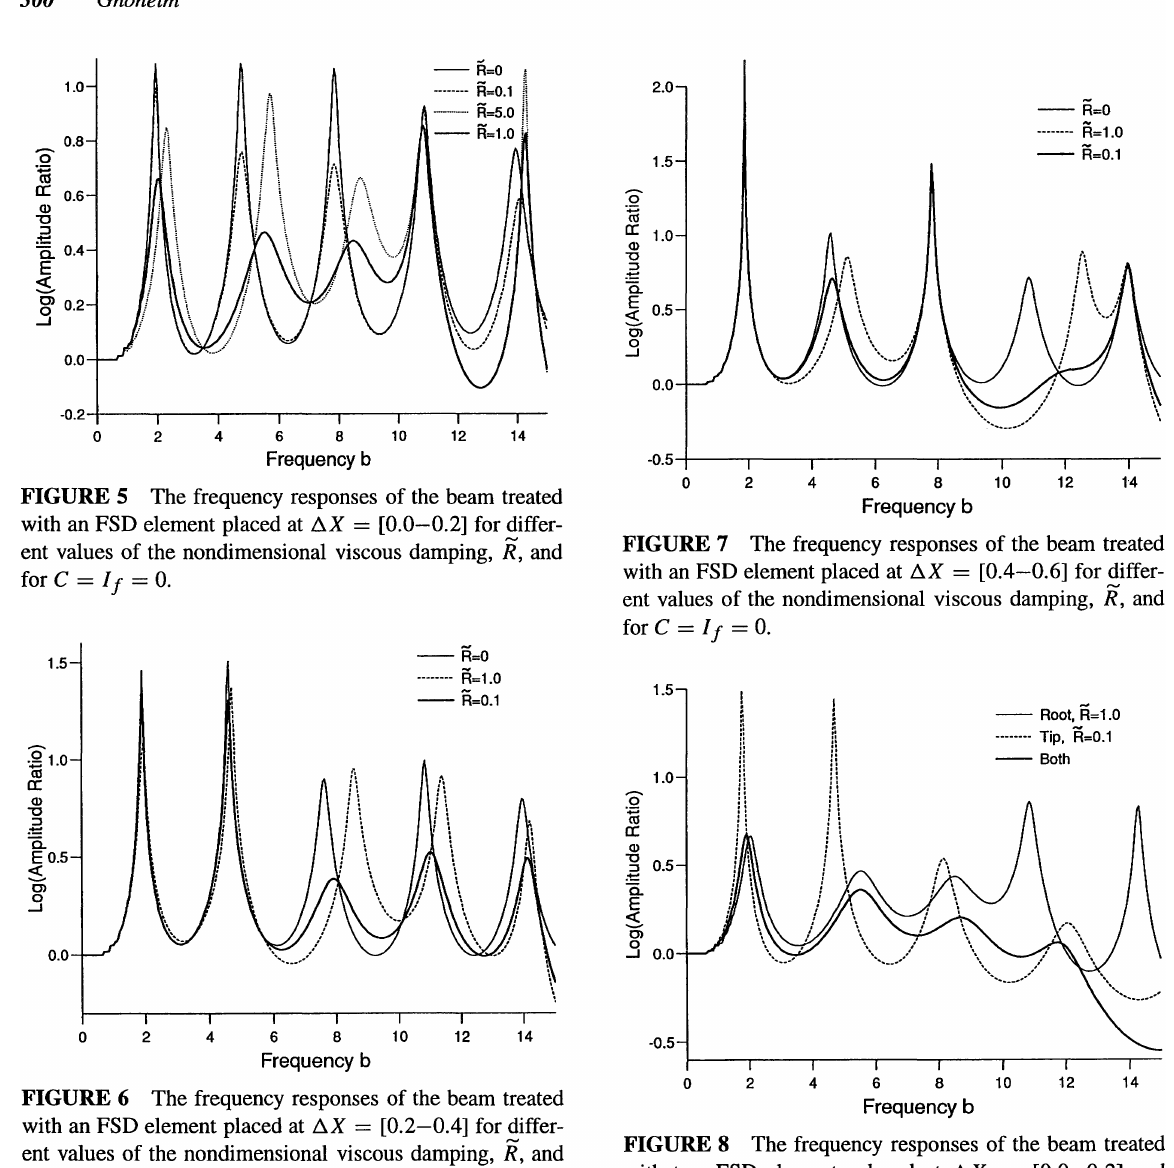
FIGURE 8 The frequency responses of the beam treated with two FSD elements placed at fl.X = [0.0-0.2] and fl.X =